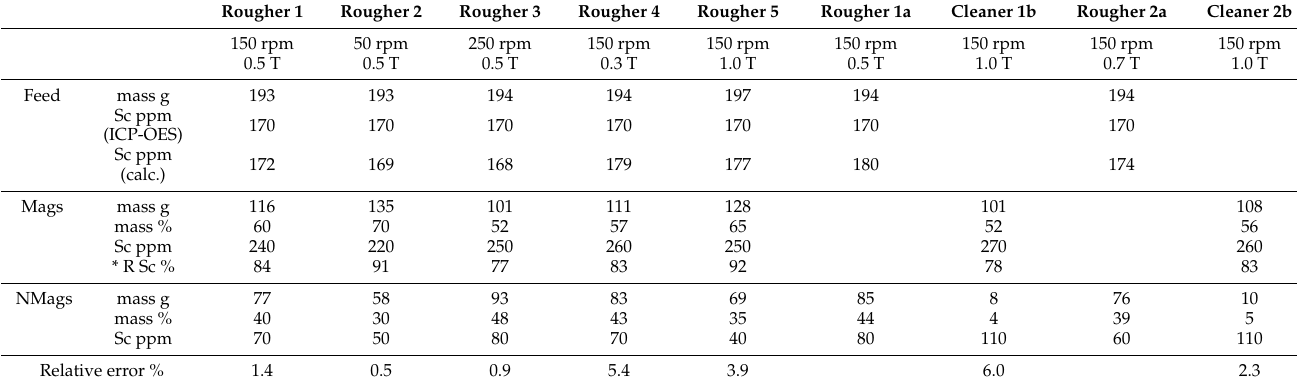
* Recovery calculated with R = Cc/(Cc + Tt) ×